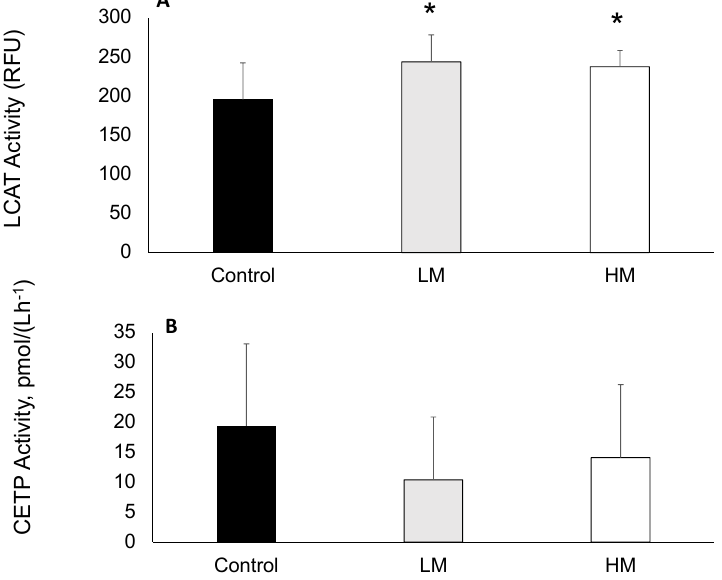
Figure 1. ( A ) Lecithin cholesterol acyltransferase (LCAT) and ( B ) Cholesterol ester transfer protein (CETP) activities of guinea pigs fed control, Low Moringa (LM; 10 g/100 g) and High Moringa (HM; 15 g/100 g) diets. * indicates significantly different from control at p < 0.01. RFU, Reference Units. Table 4. Hepatic cytokines/chemokines of guinea pigs fed a hypercholesterolemic diet with no Moringa (control), Low (10%), or High Moringa (15%) 1 .